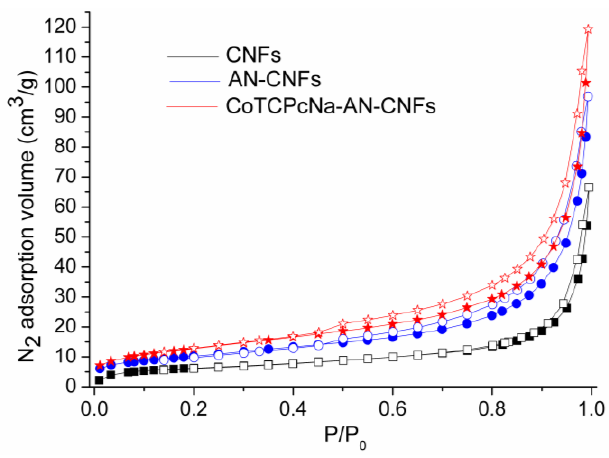
Figure 5 shows the N adsorption-desorption isotherms of CNFs, AN-CNFs and 2 CoTCPcNa-AN-CNFs. The BET surface areas of CNFs, AN-CNFs and CoTCPcNa-AN-CNFs are 22.6439, 36.4363, 46.6347 m 2 ·g −1 , respectively. The small increase of nitrogen adsorption volume suggests the disorder of CNFs was litter changed after the Billups reaction [25]. Figure 5. N adsorption-desorption 2